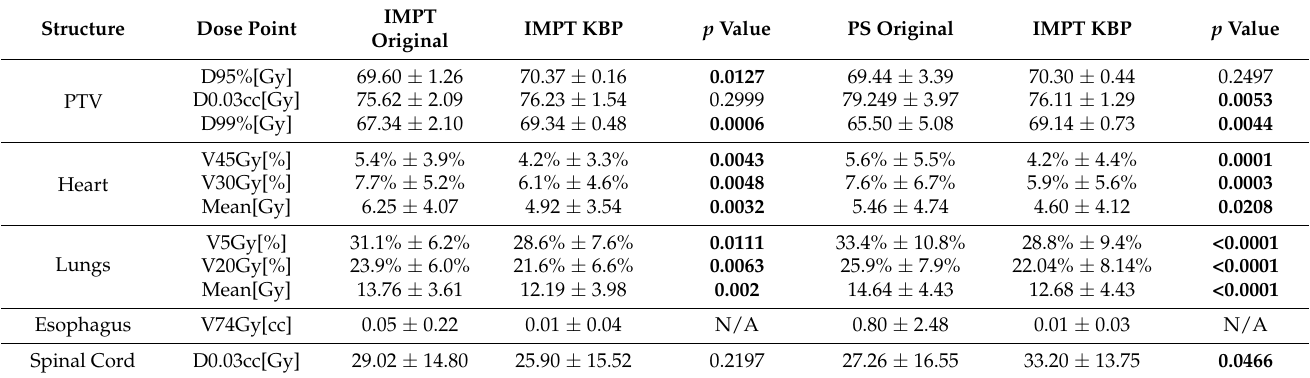
Table 5. Dose comparison and t -test results of twenty IMPT plans submitted and twenty PS plans versus KBP IMPT plans submitted in the same patients.